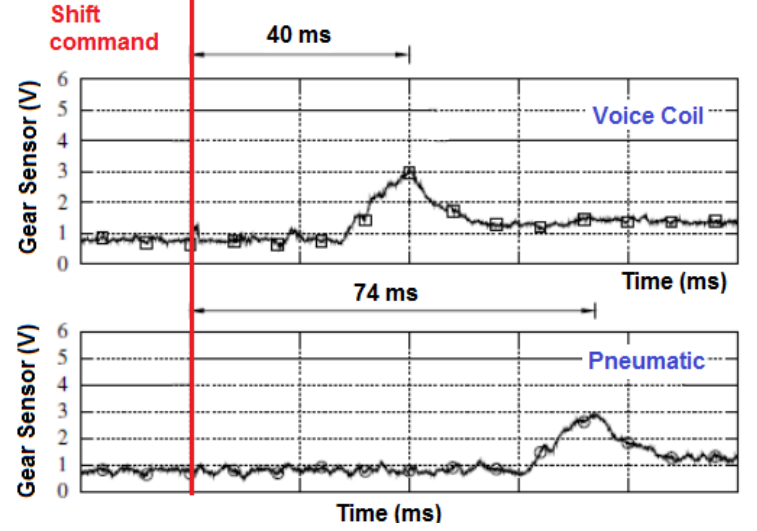
Figure 8. Experimental results of the gearbox actuation; electric ( top ) vs. pneumatic ( bottom ) actuators.